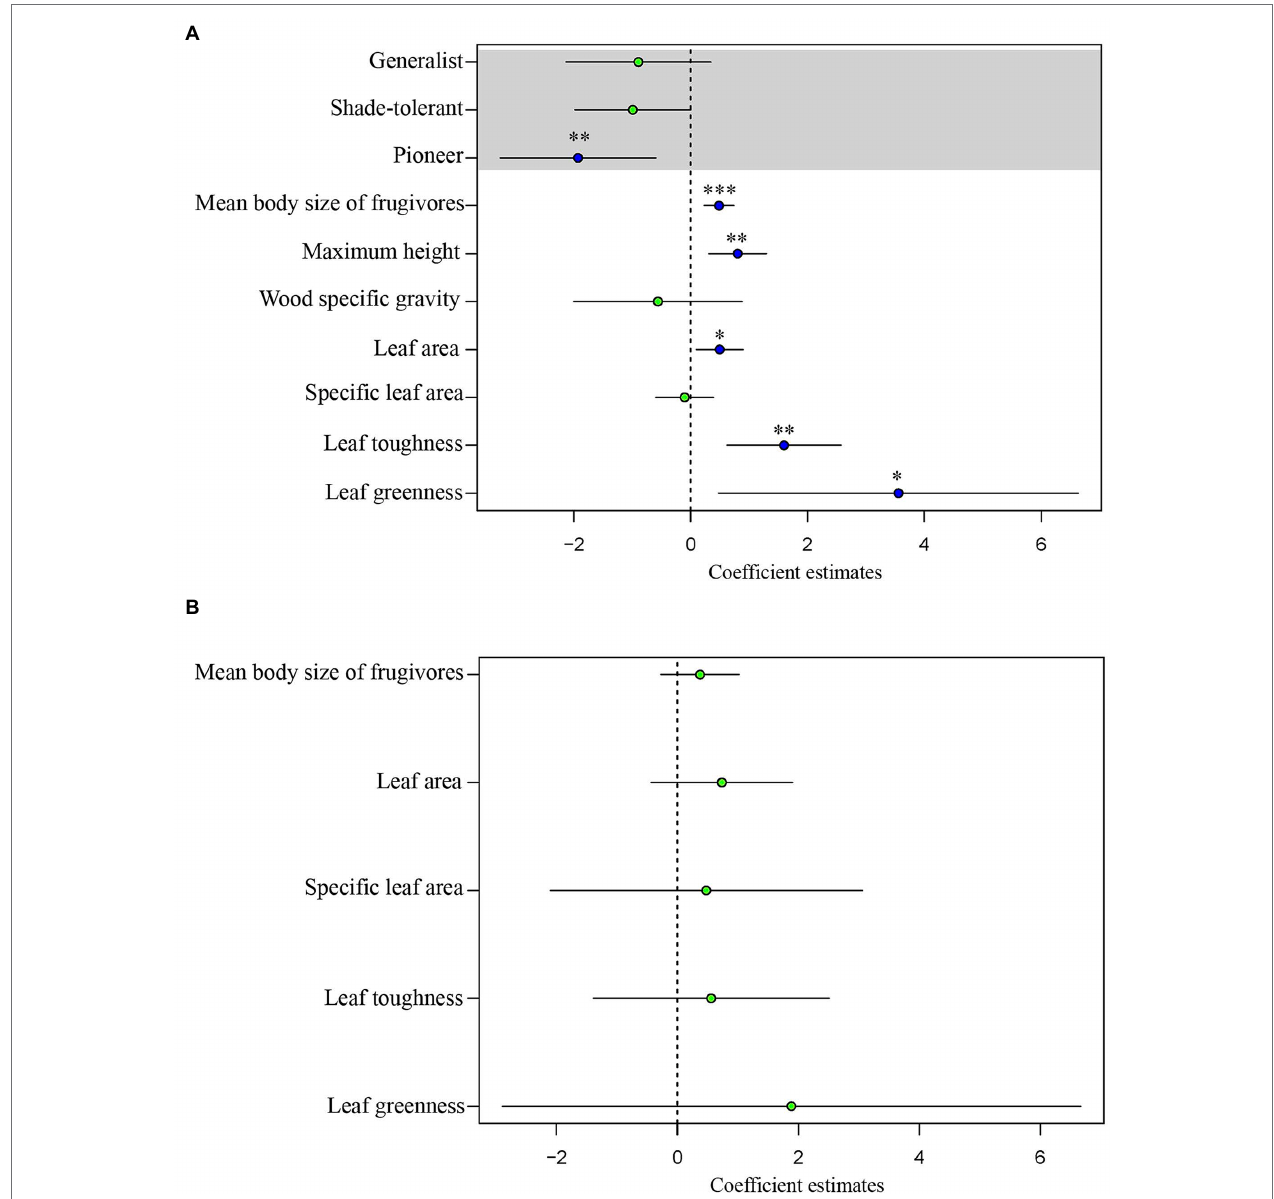
FIGURE 5 | Regression coefficients estimated through generalized least squares (GLS) analysis of seed volume of (A) trees and (B) lianas. The blue dots indicate statistically significant coefficients (* p < 0.05, ** p < 0.01, *** p < 0.001); the green dots indicate coefficients which are non-significant ( p ≥ 0.05). The horizontal bars show the 95% confidence